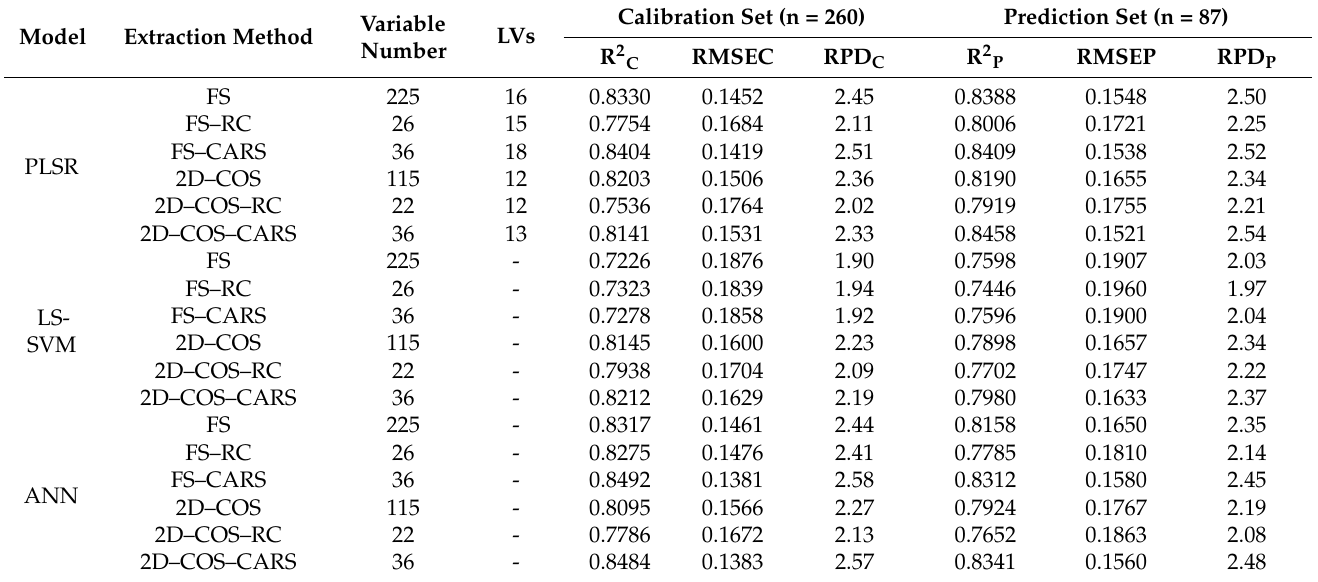
Table 6. Prediction model of Ala content established by different characteristic wavelength extraction